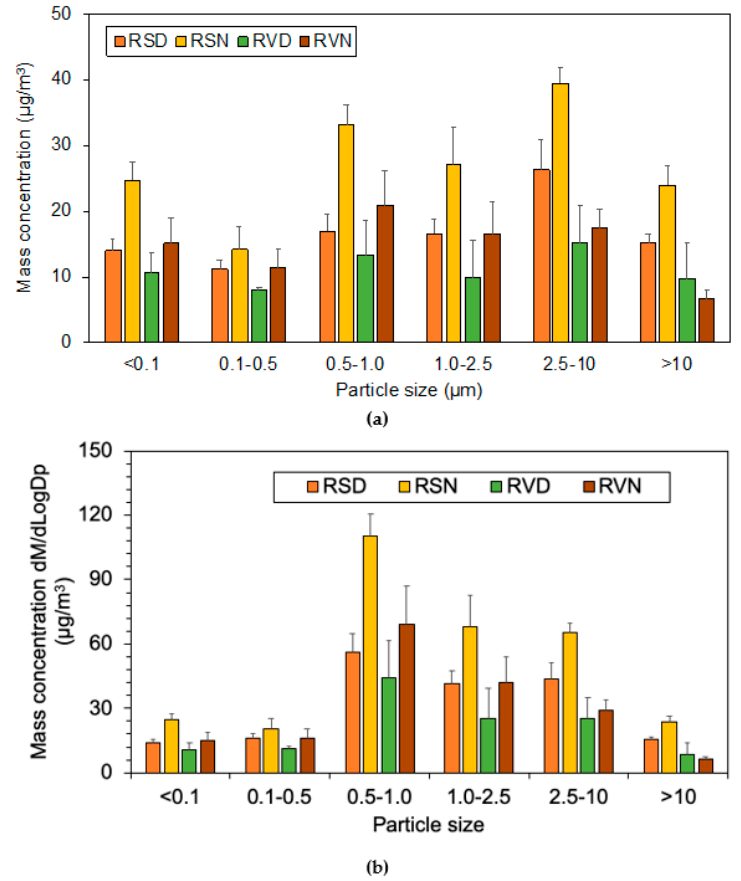
Figure 2. Average of mass ( a ) direct ( b ) dM/dLogDp concentration of each size PMs in RS and RV at diurnal and nocturnal in Jambi City.